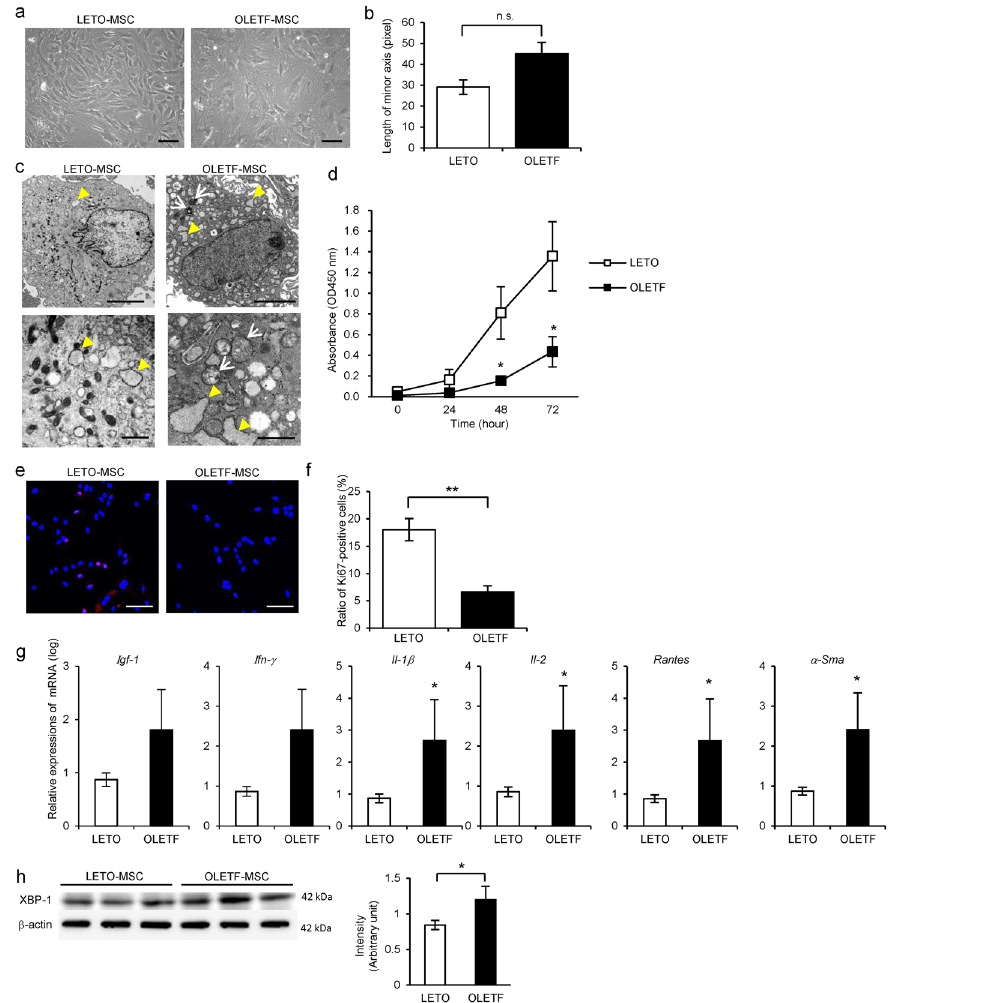
Figure 2. Abnormalities of BM-MSC isolated from Otsuka Long-Evans Tokushima Fatty (OLETF) diabetic rats (OLETF-MSC) compared with Long-Evans Tokushima Otsuka (LETO) rats (LETO-MSC). ( a ) Phase contrast images of LETO-MSC and OLETF-MSC (passage 3). Bar: 100 µ m. ( b ) Quantitative analysis morphological findings of BM-MSC. The lengths of minor axis in phase contrast images were measured in all cells in five panels of each BM-MSC isolated from individual animals. Values are means ± SE of the LETO-MSC (n = 3) and OLETF-MSC (n = 4). P = 0.0771 (not significant). ( c ) TEM images of BM-MSC. Upper panels show the entire cell at low magnification; lower panels show cell organelles at high magnification. White arrows show mitochondria degenerations. Yellow arrowheads show abnormal dilation of ER. Bar: 5 µ m in upper panels and 500 nm in lower panels. ( d ) MTT proliferation assays of LETO-MSC and OLETF-MSC. Absorbance at 450 nm was measured 0, 24, 48 and 72 hours after MTT addition. Values are means ± SE of the LETO (n = 4) and OLETF (n = 4). * P < 0.05. ( e ) Immunofluorescence staining of BM-MSC with anti-Ki-67 antibody (red). DAPI was used for counterstaining nuclei (blue). Bar: 100 µ m. ( f ) The average ratio of Ki-67-positive cells to the total cell count. The number of Ki-67-positive cells and nuclei was counted in five panels of each BM-MSC isolated from individual animals. Values are means ± SE of the LETO (n = 4) and OLETF (n = 4). ** P < 0.01. ( g ) Relative expressions of mRNA in BM-MSC. Values are means ± SE of the LETO (n = 4) and OLETF (n = 3). * P < 0.05. ( h ) Western blot analysis of LETO-MSC (n = 3) and OLETF-MSC (n = 3) using anti-XBP-1 and β -actin antibodies. Relative amounts of protein are normalized to an internal control, β -actin. The cropped images of immunoblots displayed in the figure and the full-length blots were shown in Supplementary Fig. S12. Data are expressed as mean ± SE values * P <